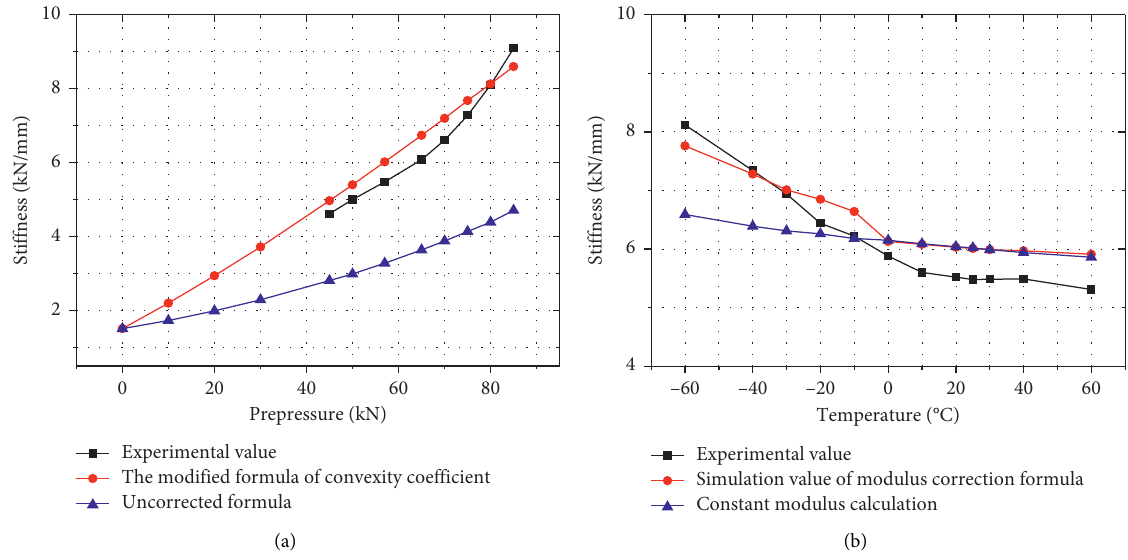
Figure 5: Comparison of measured values and theoretical model calculation. (a) Comparison of stiffness at different prepressures. (b) Comparison of stiffness at different temperatures.